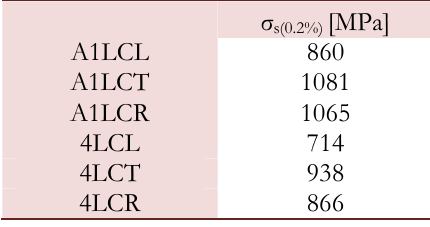
Table 5: Compression test average results